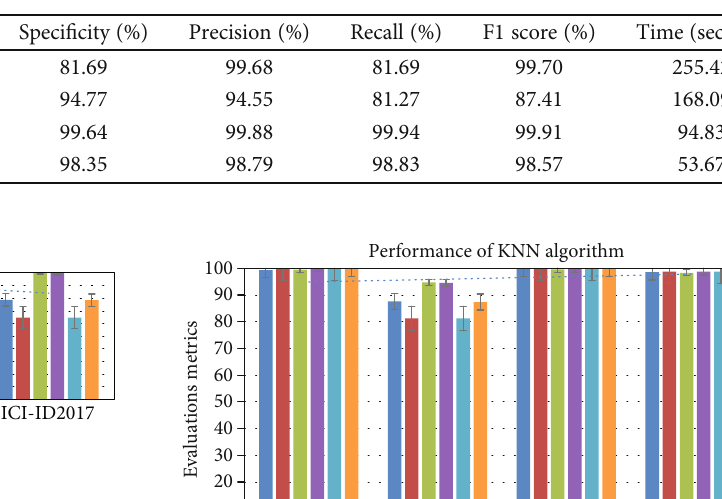
Table 9: Testing results of KNN algorithm.